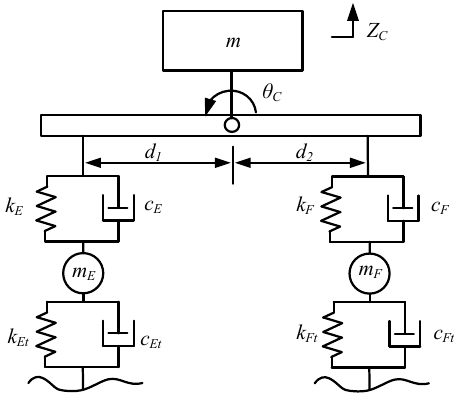
Figure 7. Dynamic model of balanced suspension.